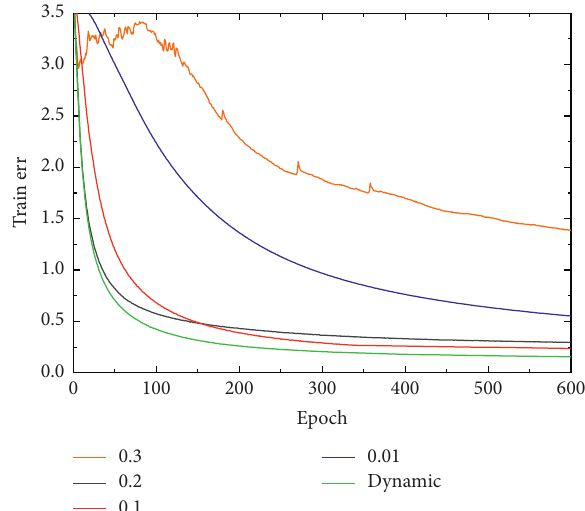
Figure 6: The training error of different learning rates.